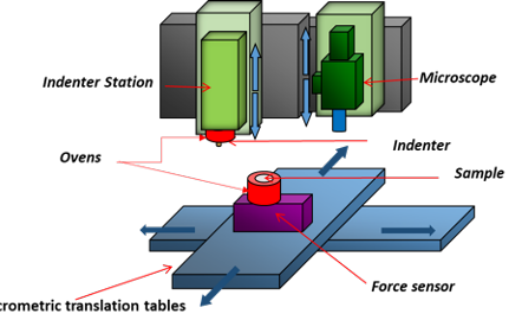
Figure 1. High temperature microhardness synoptic